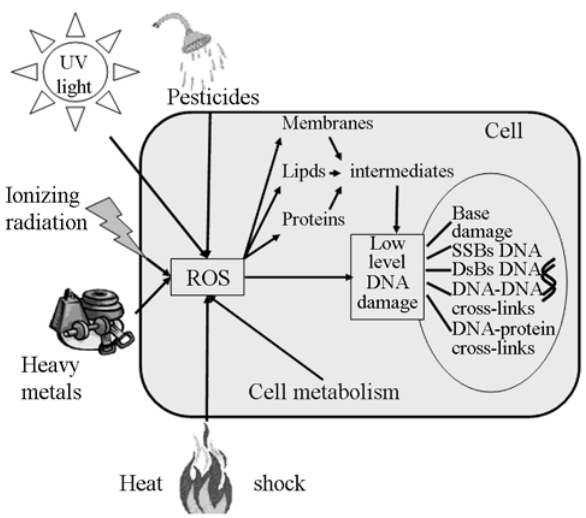
Figure 1 - Scheme of a popular hypothesis for the induction of the adap- tiveresponse(AR)viareactiveoxygenspecies(ROS)(Feinendegen etal. , 1996, 1999).